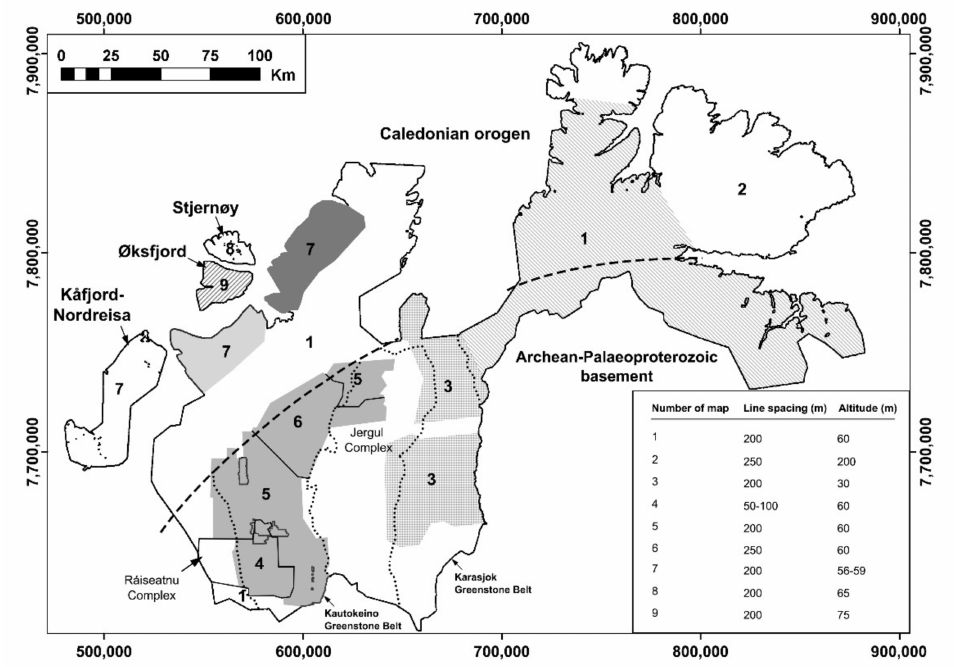
Figure A1. Aeromagnetic and radiometric survey data compilation (helicopter and fixed-wing surveys). See [41–43] and references